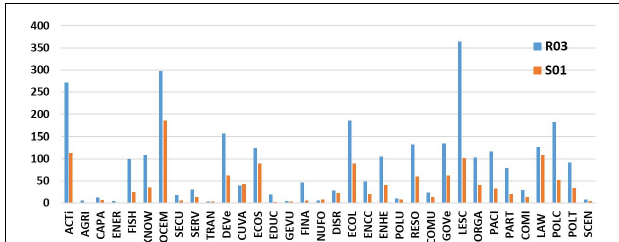
FIGURE 2 | Profiles of the Solomon Island’s policy S01 and the regional policy R03. The numbers of lemmas found in relation to each theme are indicated on the